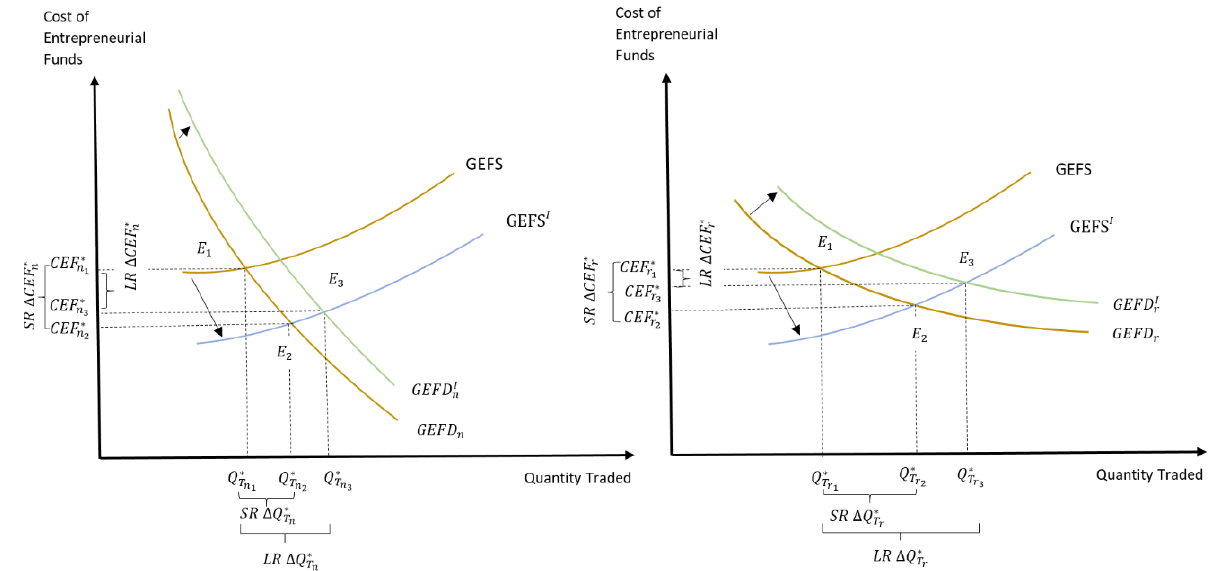
Figure 4. GEFM dynamics under public and private sectors financial injection, with endogenous financial